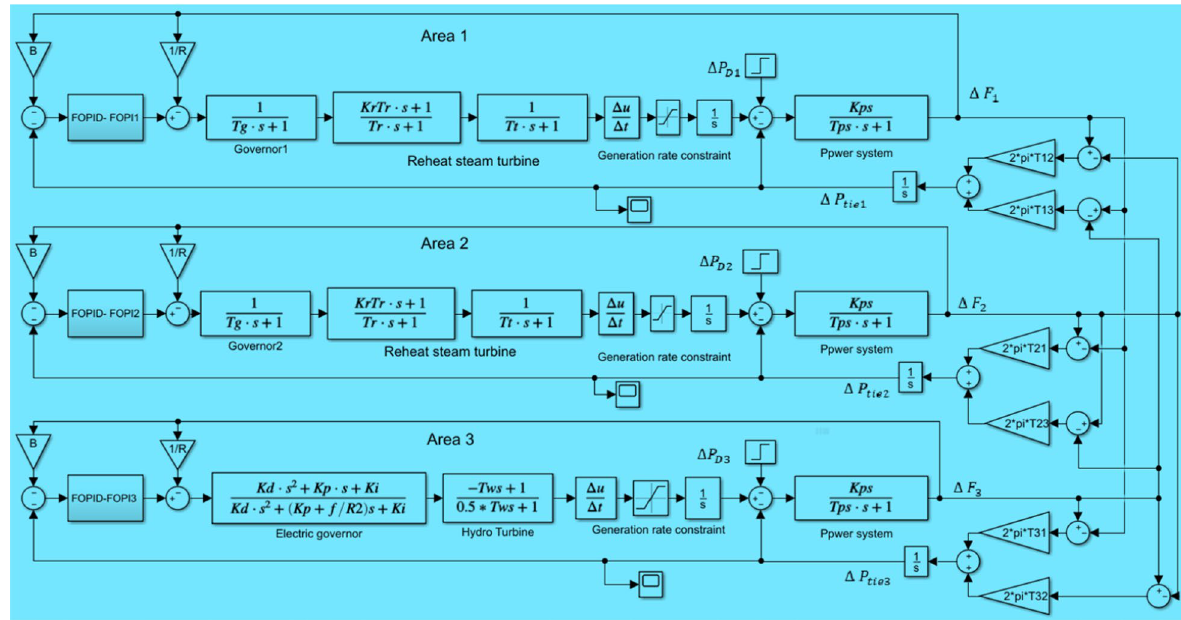
Fig. 3 TF model of three-area multi-source IPS (Test-system 4)